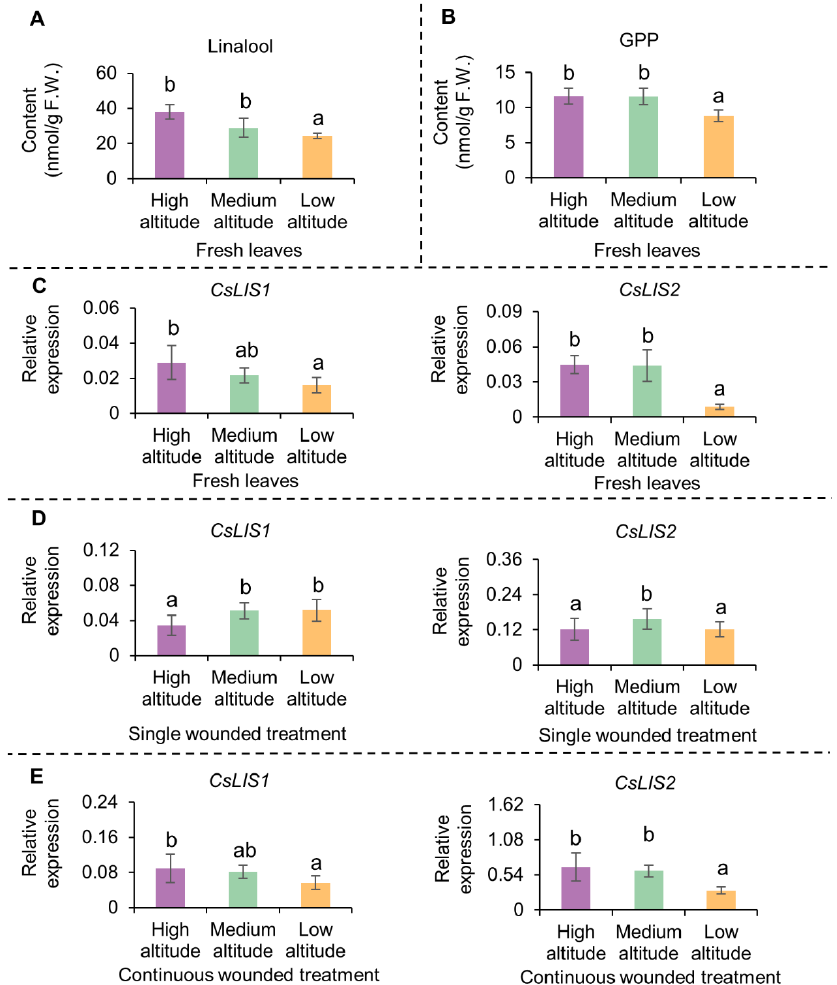
Figure 5. Contents of linalool, GPP and expression level of CsLISs in fresh leaves and wounded leaves of Lingtou Dancong grown at different altitudes. ( A ) Contents of linalool in fresh leaves; ( B ) Contents of GPP in fresh leaves. GPP, geranyl diphosphate; ( C ) Expression levels of CsLIS1 and CsLIS2 in fresh leaves ( CsEF- 1α as reference gene). LIS , linalool synthase .; ( D ) Expression levels of CsLIS1 and CsLIS2 in leaves after single wounded treatment for 3 h ( CsEF- 1α as reference gene); ( E ) Expression levels of CsLIS1 and CsLIS2 in leaves after continuous wounded treatment for 3 h ( CsEF-